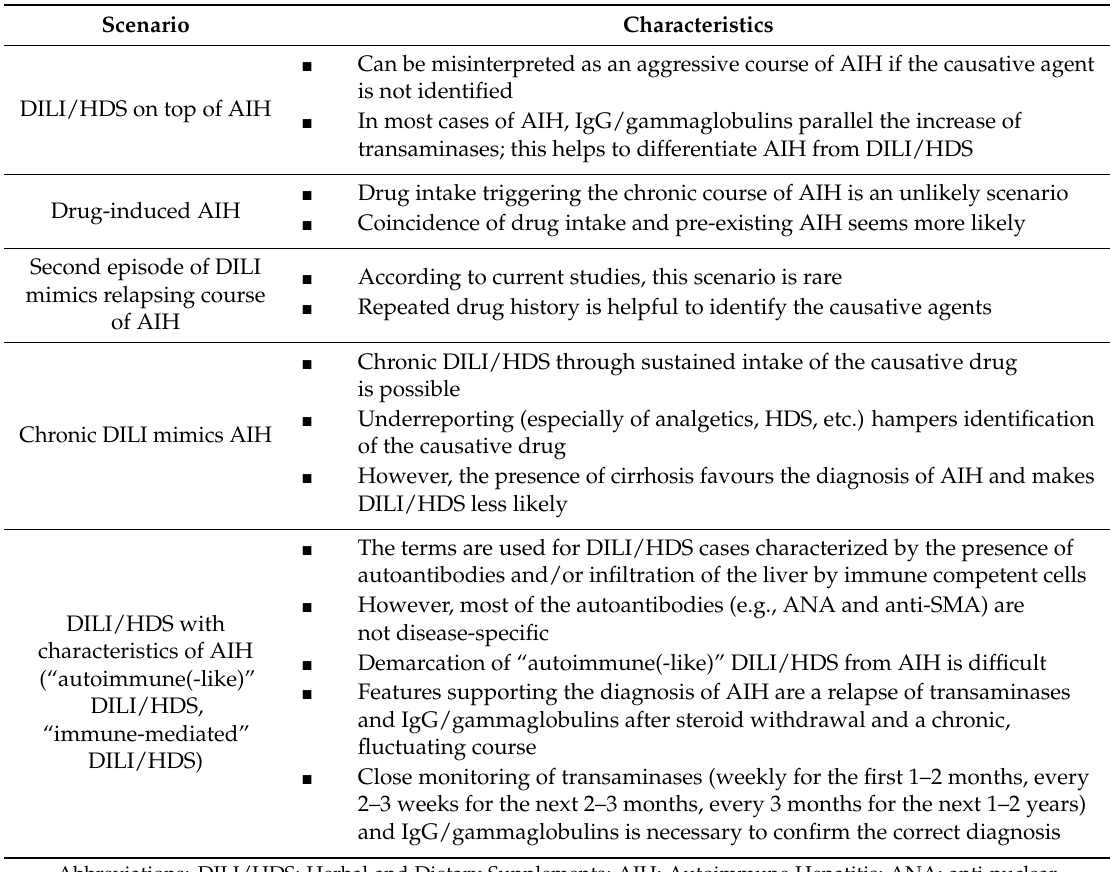
Table 1. Clinical scenarios involving both DILI/HDS and AIH.